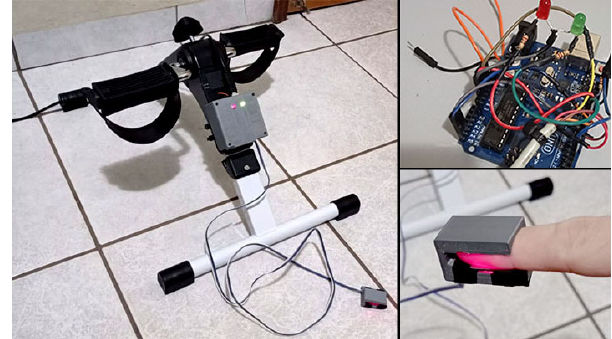
Figure 1. The cycle ergometer that was adapted for the project.